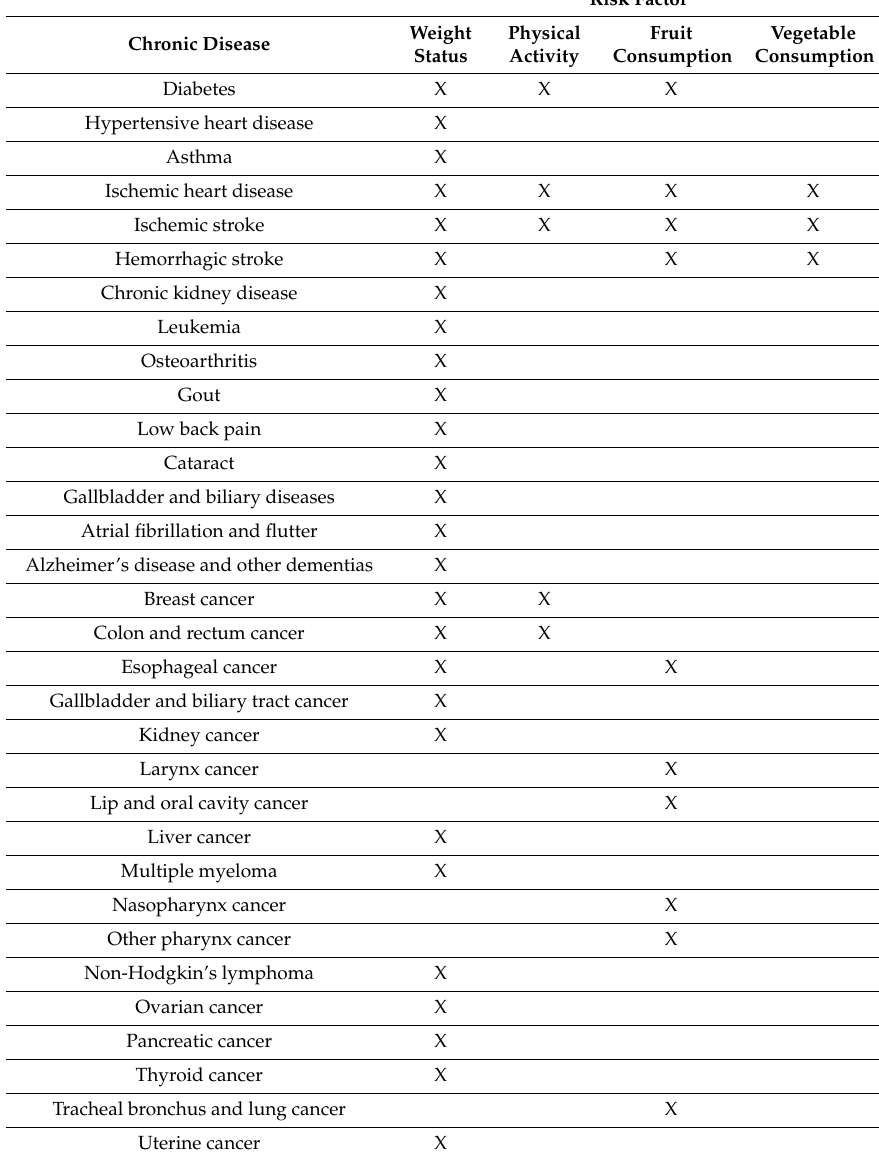
Table 1. Chronic diseases and linked risk factors